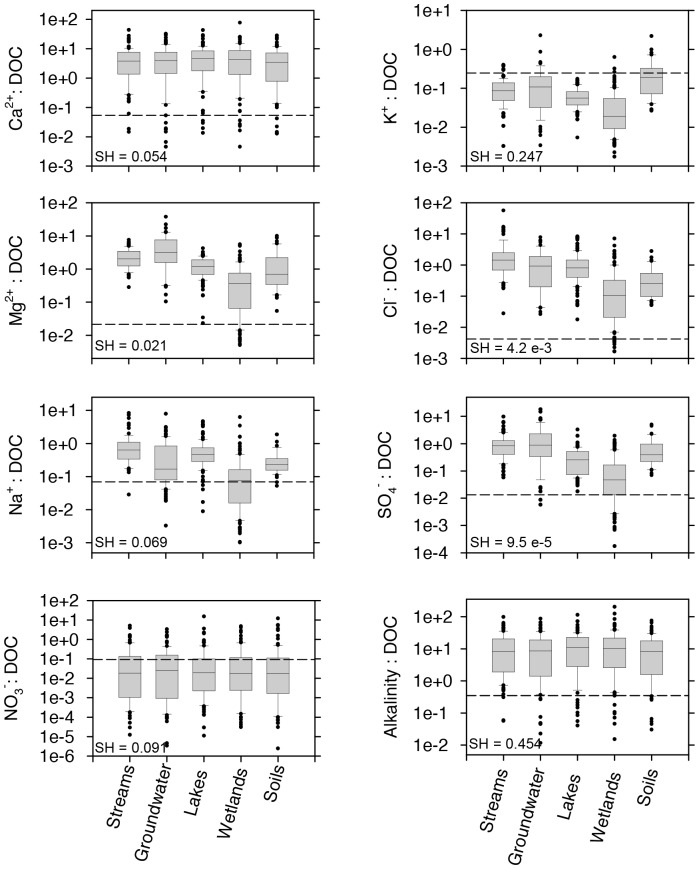
Super Hume stoichiometry.Molar ratios of major cation and anions with respect to DOC. We express alkalinity as equivalents per mole DOC. Observations for natural ecosystems (stream, groundwater, lakes, wetlands, and soil water) come from a survey of sites distributed throughout southwestern Michigan. Super Hume values are represented by the horizontal dashed line.